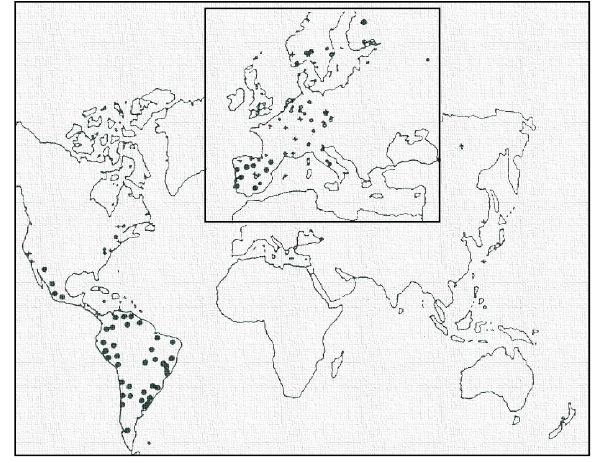
Figure 2. Atmospheric corrosion stations networks: ISOCORRAG (+), ICP (°) and MICAT ( ● ) [12].